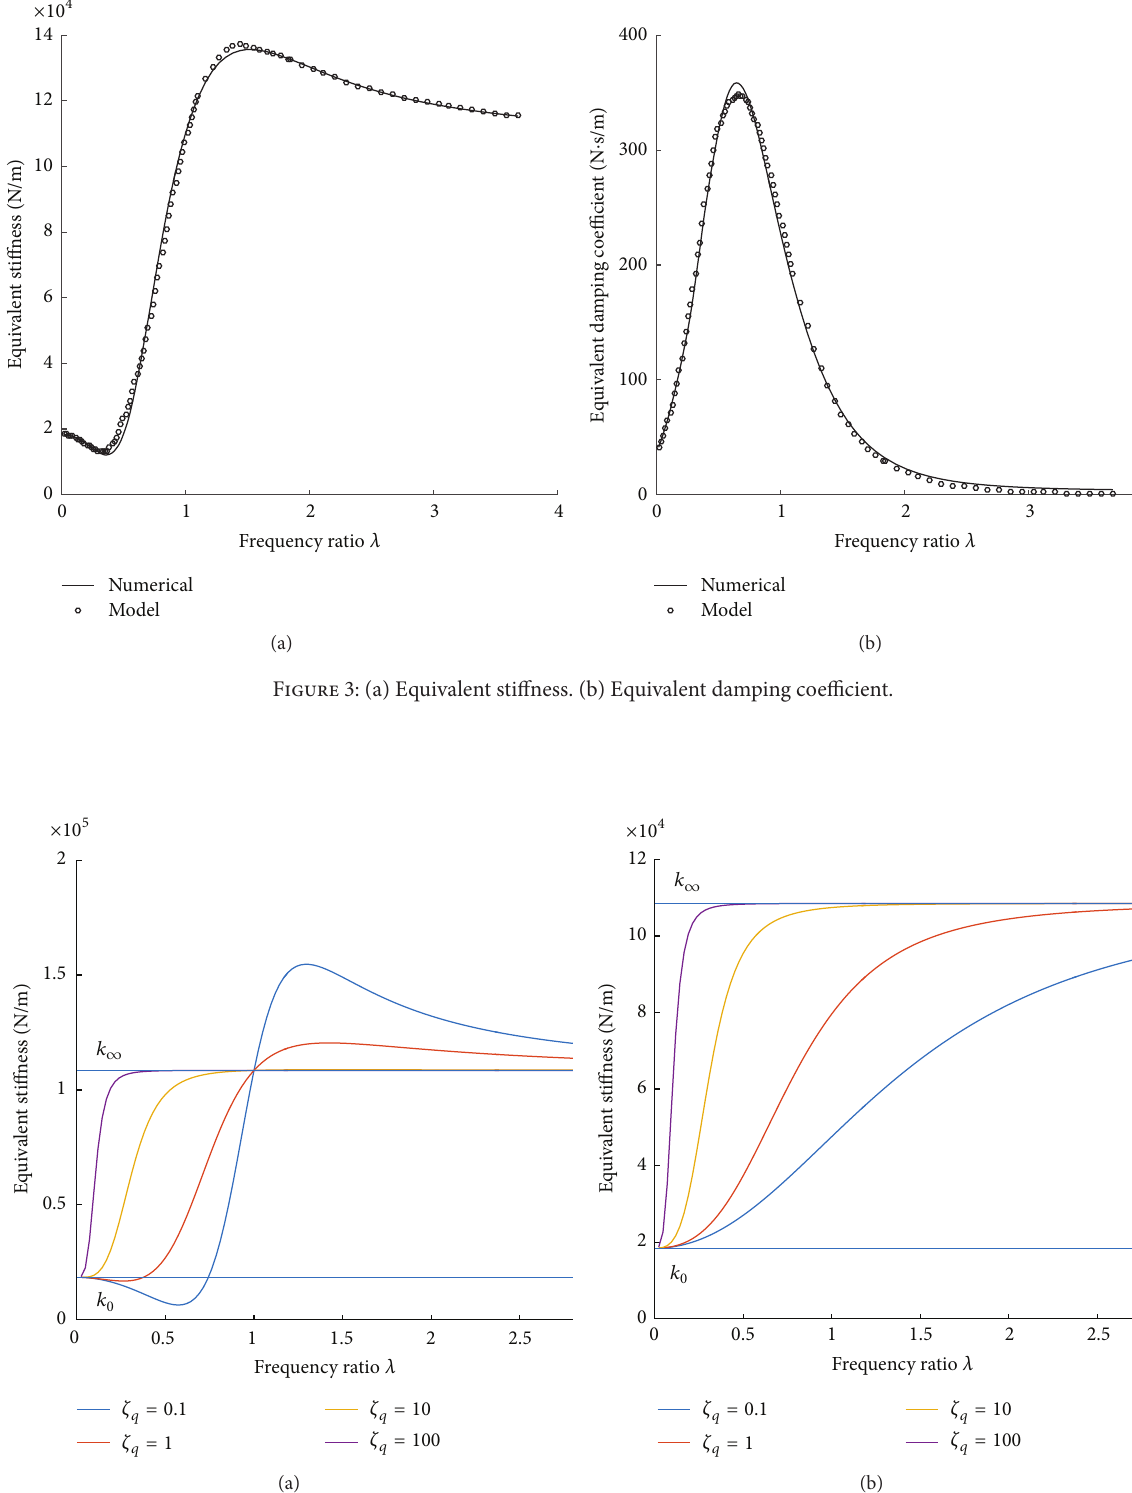
Figure 4: (a) Numerical simulations of the equivalent stiffness when 𝑚 = 0 𝑚 eq